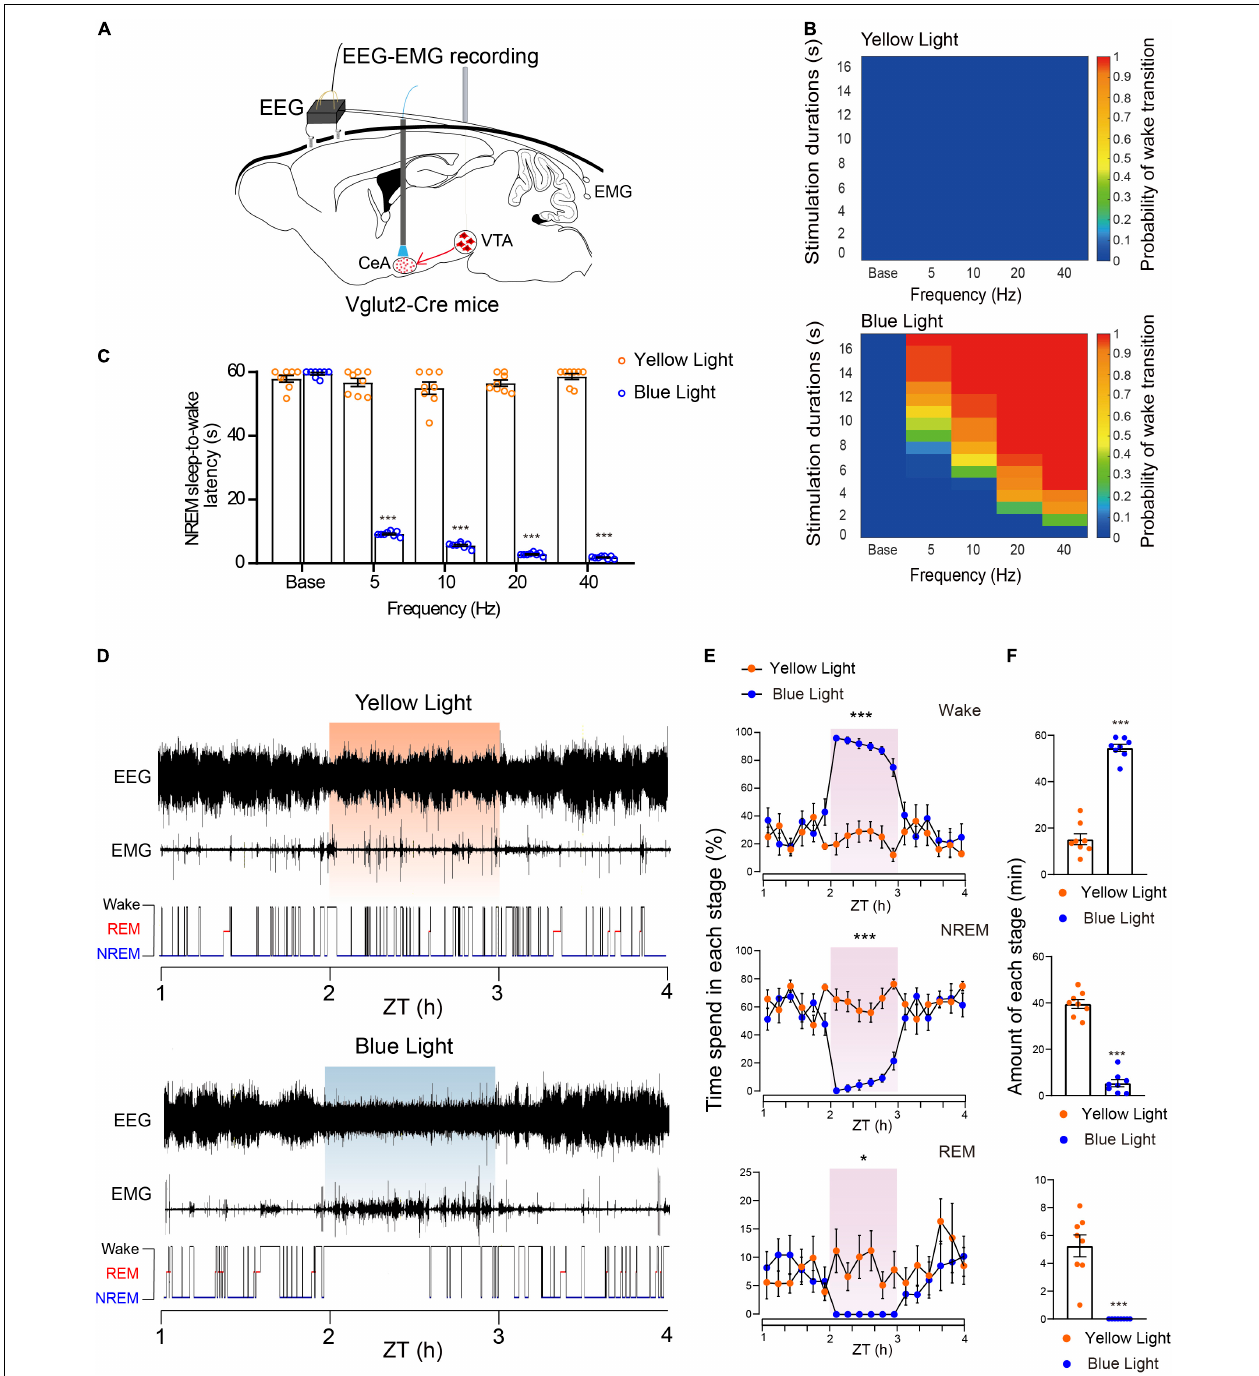
FIGURE 5 | Photoactivation of the glutamatergic VTA-CeA pathway initiates and maintains wakefulness. (A) Diagram of in vivo photostimulation and EEG and EMG recording. (B) Heat maps showing the probability of wake transition upon yellow (top) or blue (bottom) light photostimulation during NREM sleep. (C) Latencies of NREM-Wake transitions under photostimulation at different frequencies ( n = 8 per group, paired t -test; base, t 7 = 1.517, P = 0.1730; 5 Hz, t 7 = 32.96, P < 0.001; 10 Hz, t 7 = 24.58, P < 0.001; 20 Hz, t 7 = 53.77, P < 0.001; 40 Hz, t 7 = 60.33, P < 0.001). (D) Example of EEG/EMG traces showing the effect of light stimulation of the glutamatergic VTA-CeA pathway on sleep–wake behaviors. (E) Time course change of sleep–wake behaviors during long-term photostimulation of the glutamatergic VTA-CeA pathway during ZT 02:00–03:00 [ n = 8, two-way repeated-measures ANOVA; wake F (1,14) = 103.0, P < 0.001; NREM F (1,14) = 78.63, P < 0.001; REM F (1,14) = 8.604, P = 0.0109]. (F) Sleep and wake amount during ZT 02:00–03:00 light stimulation ( n = 8, paired t -test; Wake t 7 = 22.77, P < 0.001; NREM t 7 = 27.37, P < 0.001; REM t 7 = 6.615, P = 0.0003). Data are expressed as mean ± SEM. * P < 0.05, *** P < 0.001.